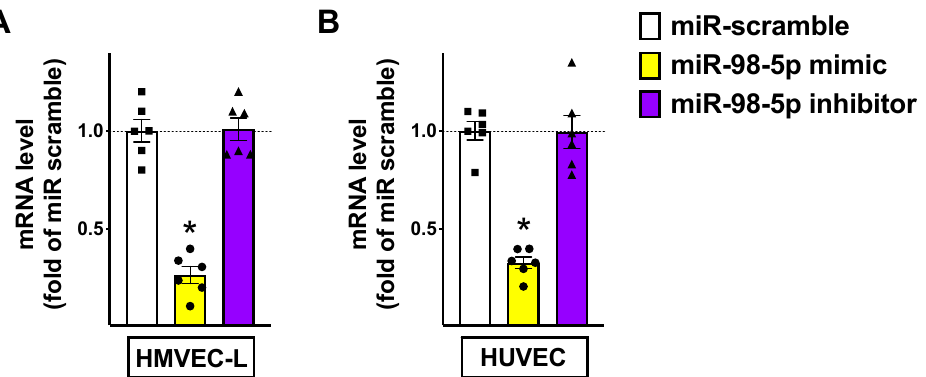
Figure 3. TMPRSS2 expression in human endothelial cells is reduced by miR-98-5p. TMPRSS2 mRNA levels were measured in HMVEC-L ( A ) as well as in HUVEC ( B ) transfected with miR-98-5p mimic, inhibitor, or scramble (negative control) for 48 h. Means ± S.E.M. are shown alongside actual values; * p <0.05 vs. miR scramble.